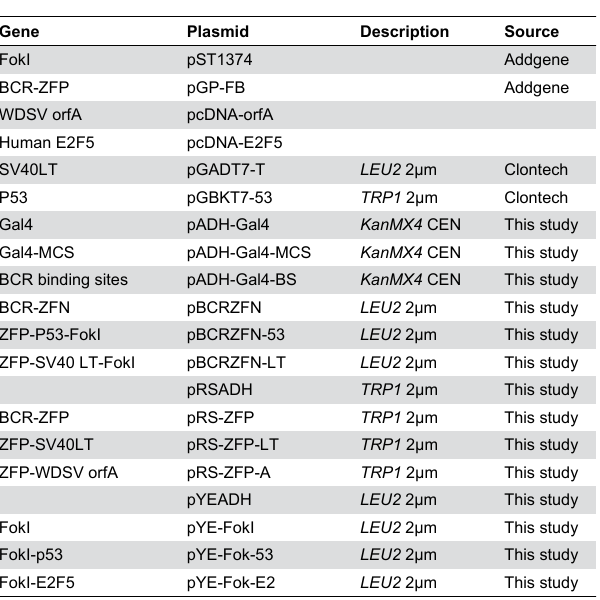
Table 1. Plasmids used in this